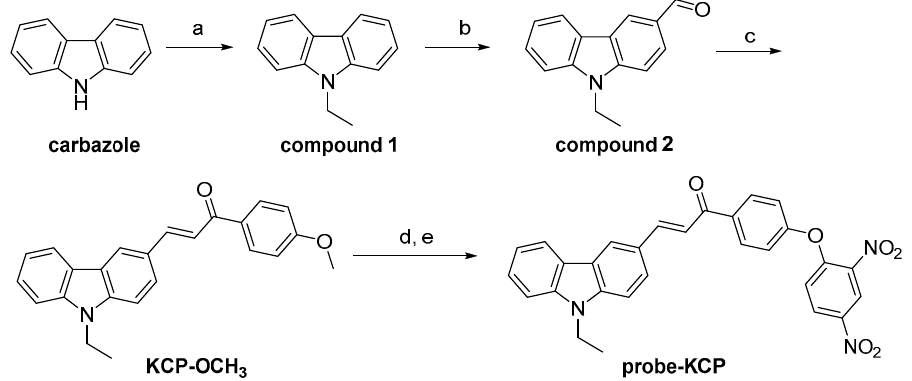
Scheme 1. The synthetic routes and the chemical structures of the probe ‐ KCP. Reagents and conditions